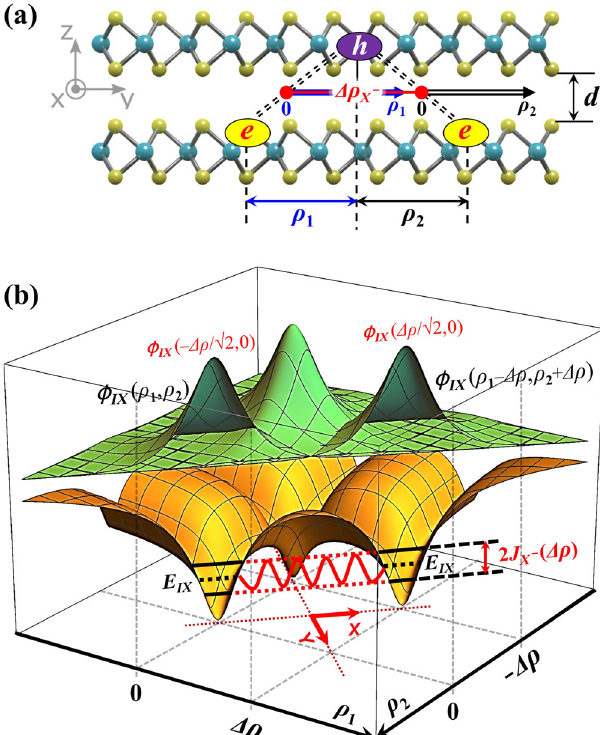
Fig. 5 Con fi guration space view. a The structure of a negatively charged interlayer exciton (CIE) complex in a transition metal dichalcogenide (TMD) bilayer of the interlayer separation d . The complex can be viewed as a pair of equivalent interlayer excitons (IEs) sharing the same hole — both represented by their relative electron-hole distance in-plane projections ρ 1 and ρ 2 treated independently, with Δ ρ X (cid:2) being the interexciton center-of- mass-to-center-of-mass distance. b The same structure in the orthogonal con fi guration space ( ρ 1 , ρ 2 ) of the two equivalent independent IEs separated by the center-of-mass-to-center-of-mass distance Δ ρ ( ¼ Δ ρ X (cid:2) for the negative CIE here). The diagonal crosscut illustrates the tunnel exchange between the two equivalent IEs in ( a ). The system tunnels through the potential barrier formed by the two single-exciton Coulomb interaction potentials (bottom, yellow) given by the second line in Eq. (6), between the equivalent states (top, green) represented by the isolated two-exciton wave functions in Eq. (13). Due to the IE ground-state splitting, this tunnel exchange coupling lowers the ground-state energy of the system by the amount of J X (cid:2) ð Δ ρ Þ , the tunnel exchange integral given by Eq. (17), to form the negative CIE complex. ∂ ∂ ∂ ∂ ^ H ð ρ ; ρ ; Δ ρ ; d Þ ¼(cid:2) 1 ρ (cid:2) 1 ρ ρ ∂ ρ ∂ ρ ρ ∂ ρ ∂ ρ 1 2 1 2 q(cid:3) (cid:4) q(cid:3) (cid:4) q(cid:3) (cid:4) 1 1 1 2 2 2 ffiffiffiffiffiffiffiffiffiffiffiffiffiffiffi ffiffiffiffiffiffiffiffiffiffiffiffiffiffiffi ffiffiffiffiffiffiffiffiffiffiffiffiffiffiffiffiffiffiffiffiffiffiffiffiffiffiffiffiffiffi ρ 2 ρ 2 þ V þ V þ V þ d 2 þ d 2 Δ ρ Þ 2 þ d 2 ð ρ C C C 1 2 1 ± ð 6 Þ q(cid:3) (cid:4) ffiffiffiffiffiffiffiffiffiffiffiffiffiffiffiffiffiffiffiffiffiffiffiffiffiffiffiffiffiffiffi þ V (cid:8) Δ ρ Þ 2 þ d 2 ð ρ C 2 (cid:7) ðj σ ð ρ (cid:2) ρ Þ = λ þ Δ ρ jÞ ! X þ þ 2 V KR : 1 2 V KR ðjð ρ 1 (cid:2) ρ 2 Þ = λ (cid:2) Δ ρ jÞ ! X (cid:2) The “ atomic units ” are used with distance and energy measured in the units of exciton Bohr radius a (cid:3) B ¼ 0 : 529 Å ε = μ and Rydberg energy Ry (cid:3) ¼ _ 2 = ð 2 μ m 0 a (cid:3) 2 B Þ ¼ e 2 = ð 2 ε a (cid:3) B Þ ¼ 13 : 6 eV μ = ε 2 , respectively 37 – 41 , λ m λ = 1 + σ stands for the exciton reduced effective mass μ = m e /( 0 ) with (in the units of free electron mass m 0 ), σ = m e / m h is the electron-to-hole